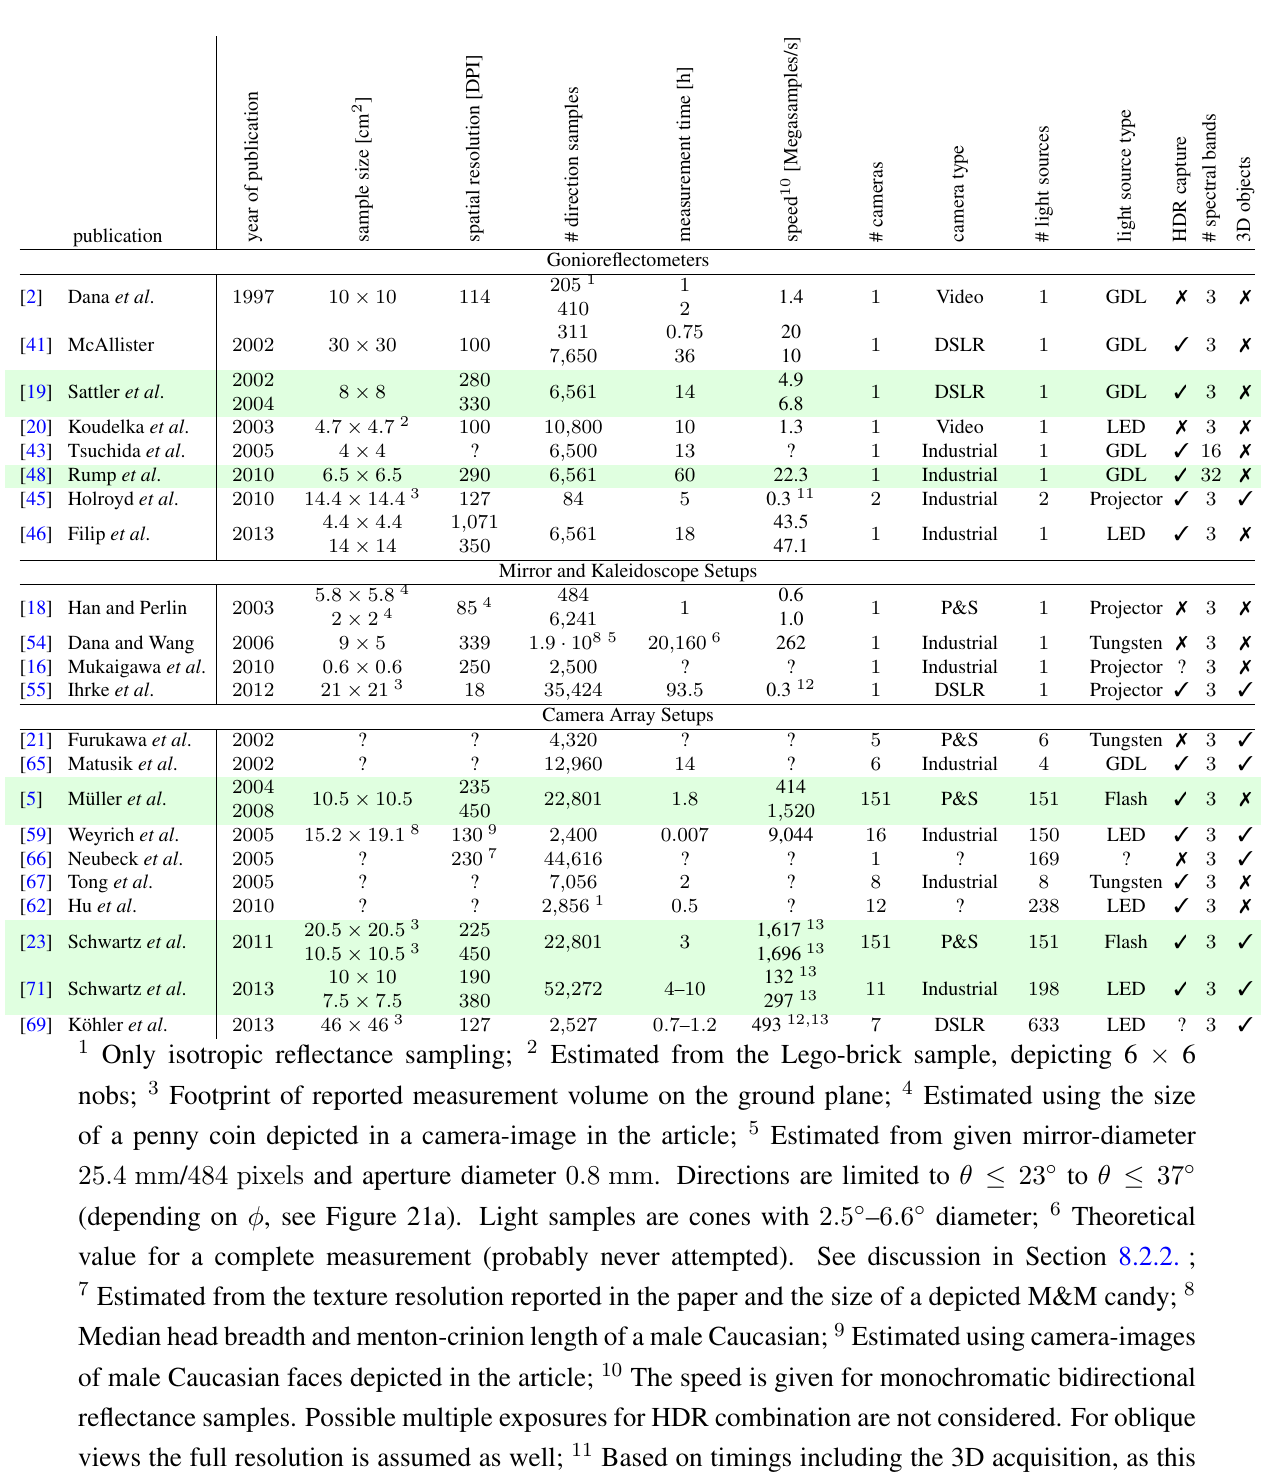
Table 6. Comparison with other setups. Our setups are shaded in green. The numbers of other setups are compiled from publicly available sources: the cited original research publications, associated technical reports, state-of-the-art reports and courses covering the devices as well as websites of accompanying databases or laboratories. Some figures have not been directly reported and are instead derived from the available material (see footnotes). GDL stands for gas discharge